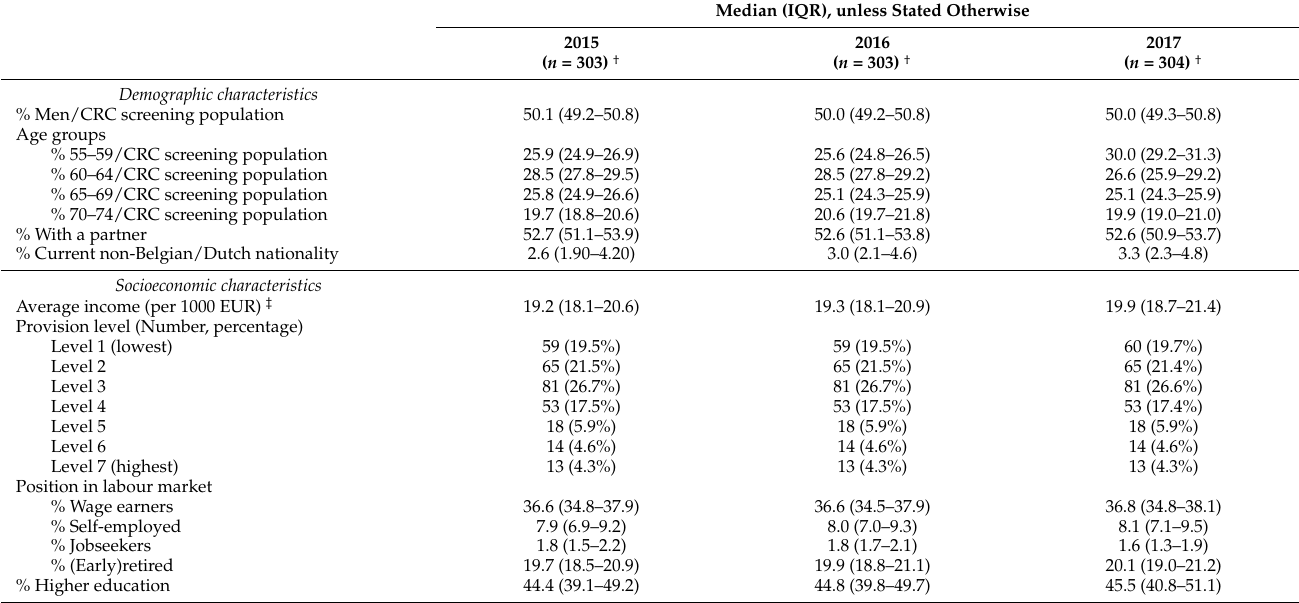
Table 2. Demographic, socioeconomic and health-related characteristics of all 308 municipalities in Flanders, 2015–2017. Median (IQR), unless Stated